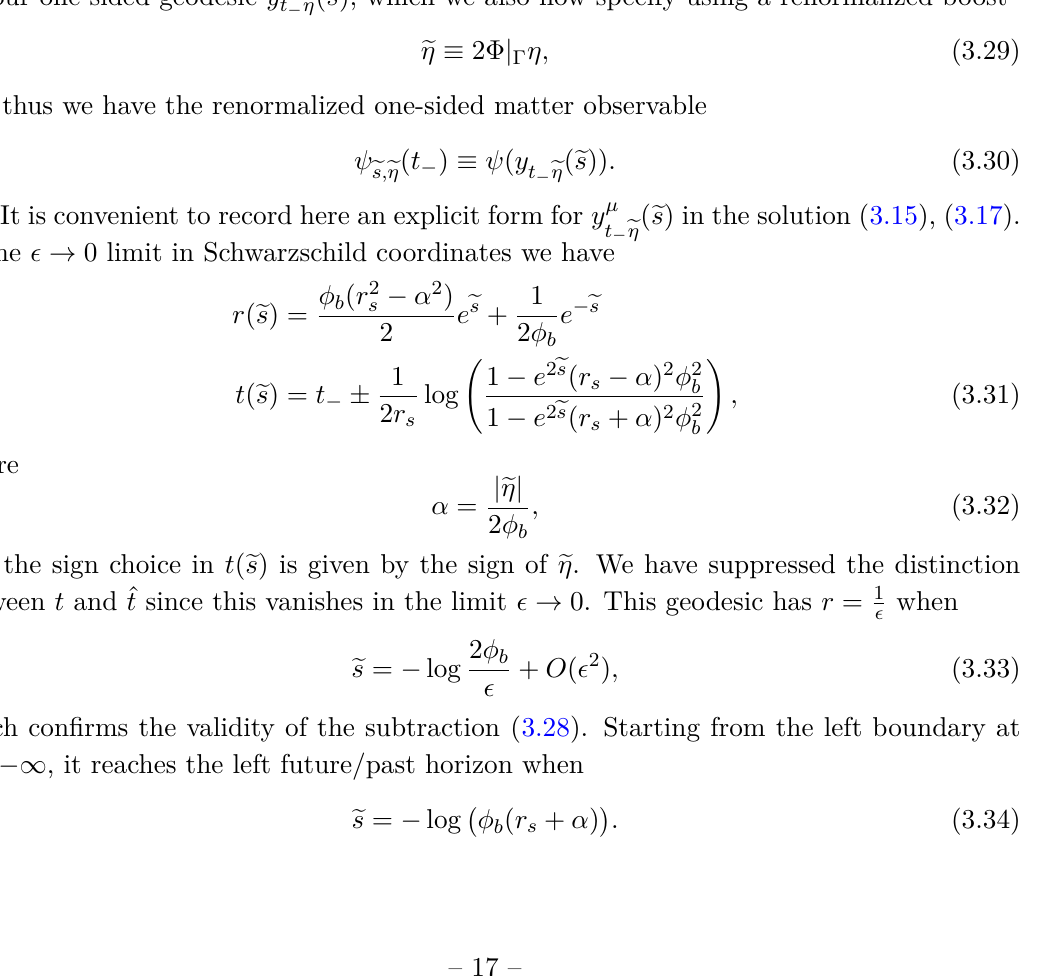
Figure 5 . Some examples of the one-sided geodesic y µ in the pure JT solution (3.15). Geodesics for other starting times are obtained by acting with the boost isometry of this solution. The dashed lines are horizons, and the spacetime region whose properties are determined by the initial data on any Cauchy slice connecting the two boundaries and the boundary conditions (3.2) is shaded